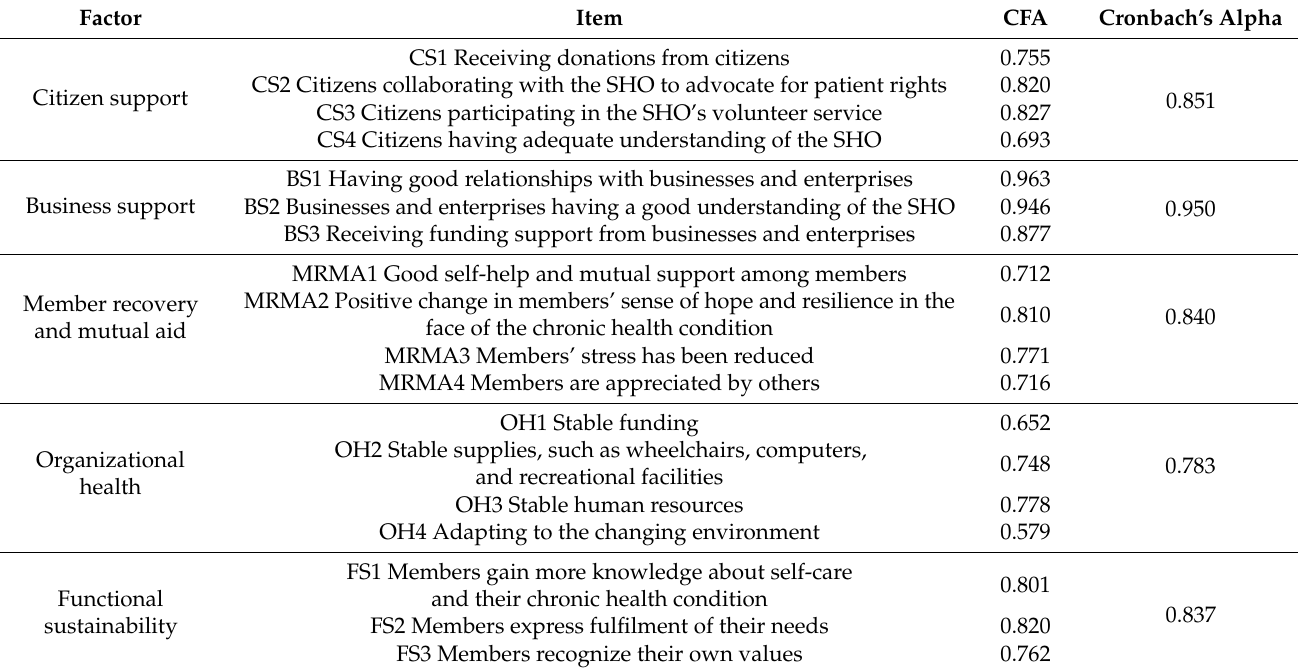
Table 3. Standardized factor loadings.